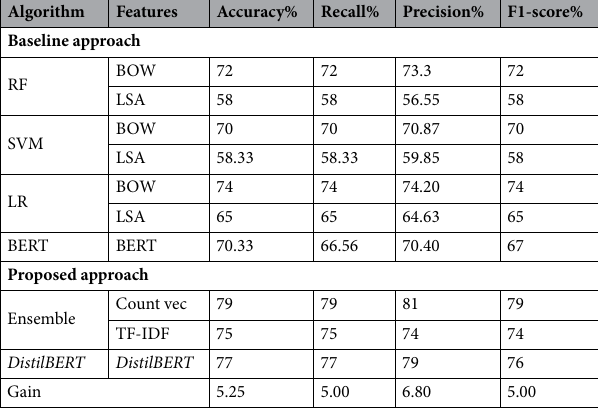
Table 9. Performance comparison of proposed approach and baseline approach with 20 authors.